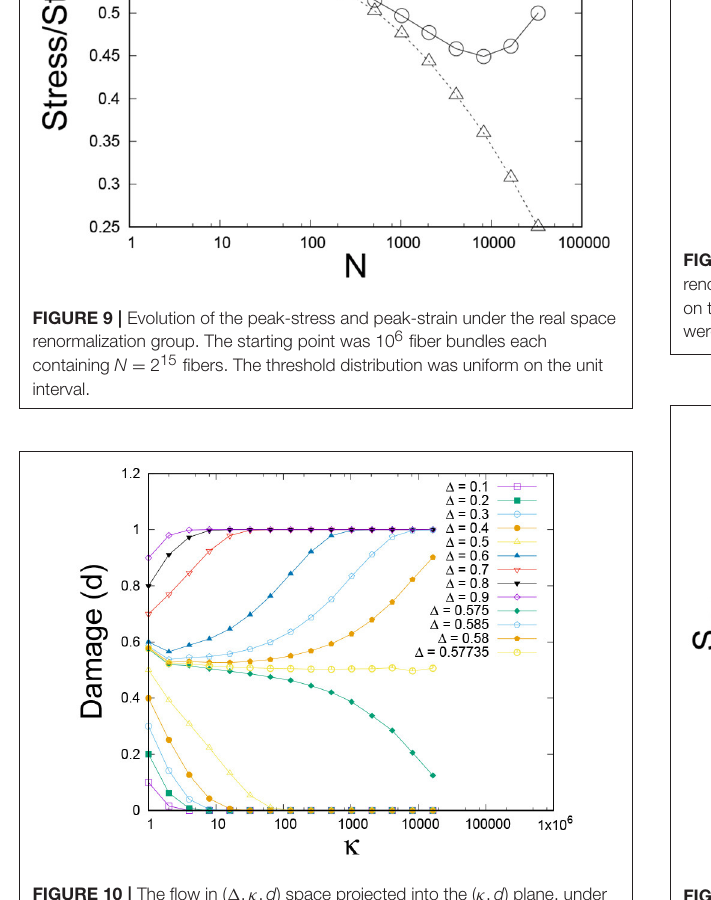
FIGURE 12 | Evolution of the largest avalanche occurring before complete 2 15 having failure as the real space renormalization group is iterated. The initial threshold = distribution was uniform on the unit interval. The initial number of fibers was N 2 14 and averages were taken over 10 5 =